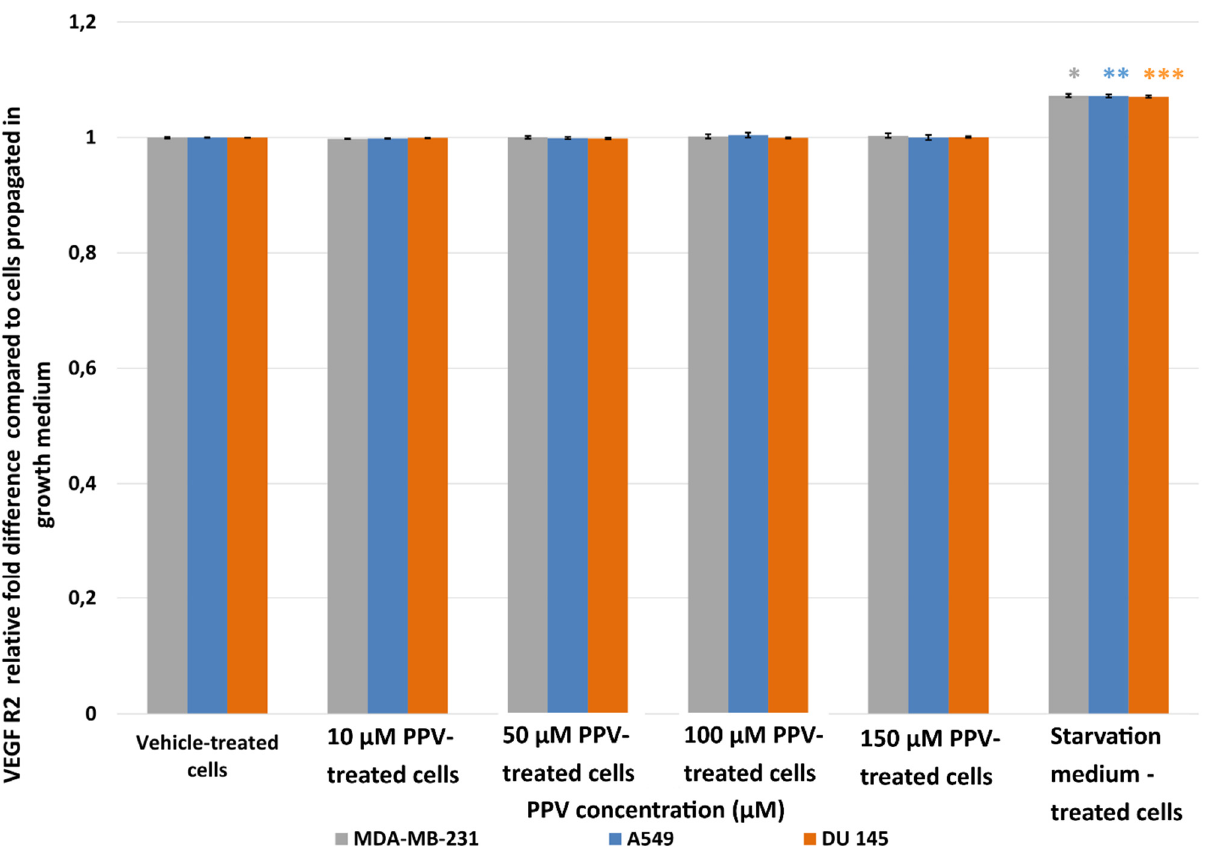
Figure 7. Spectrophotometry results of VEGF R2 ELISA demonstrating the effects of PPV (10–300 µ M) on proliferation on MDA-MB-231 cells compared to A549- and DU145 cell lines at 48 h. The average of three independent experiments is represented by the graph with error bars indicating standard deviation. The statistical significance of MDA-MB-231 cells is indicated with an asterisk (*), the statistical significance of A549 cells is indicated with two asterisks (**), and the statistical significance of DU145 cells is indicated with three asterisks (***). Statistical significance is represented by an * when using the student t -test with a p value of 0.05 compared to cells propagated in complete growth medium.